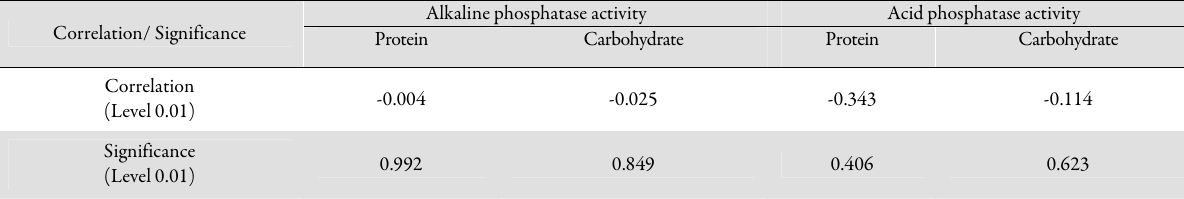
Tab. 2. Correlation of alkaline and acid phosphatase activity with protein